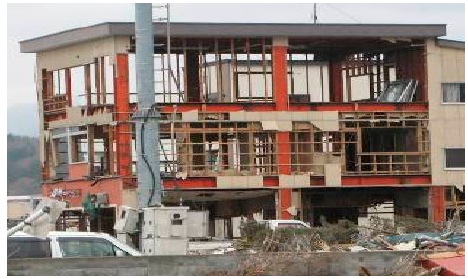
Figure 23. Steel building, inundation depth 7.5 m, panel wall destruction, Yamada-cho.